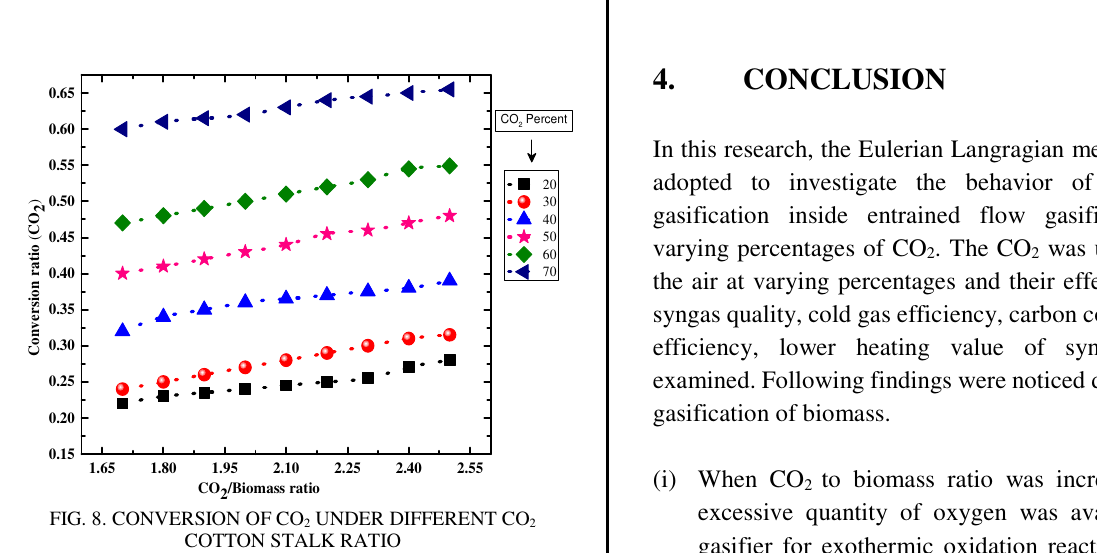
FIG. 7. BEHAVIOR OF CGE UNDER VARYING CO 2 /COTTON STALK RATIO